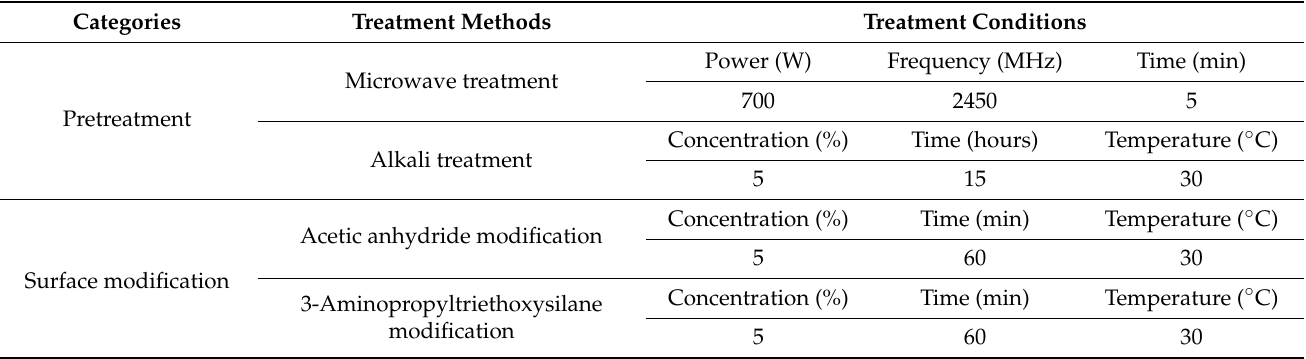
Table 1. Conditions of each treatment